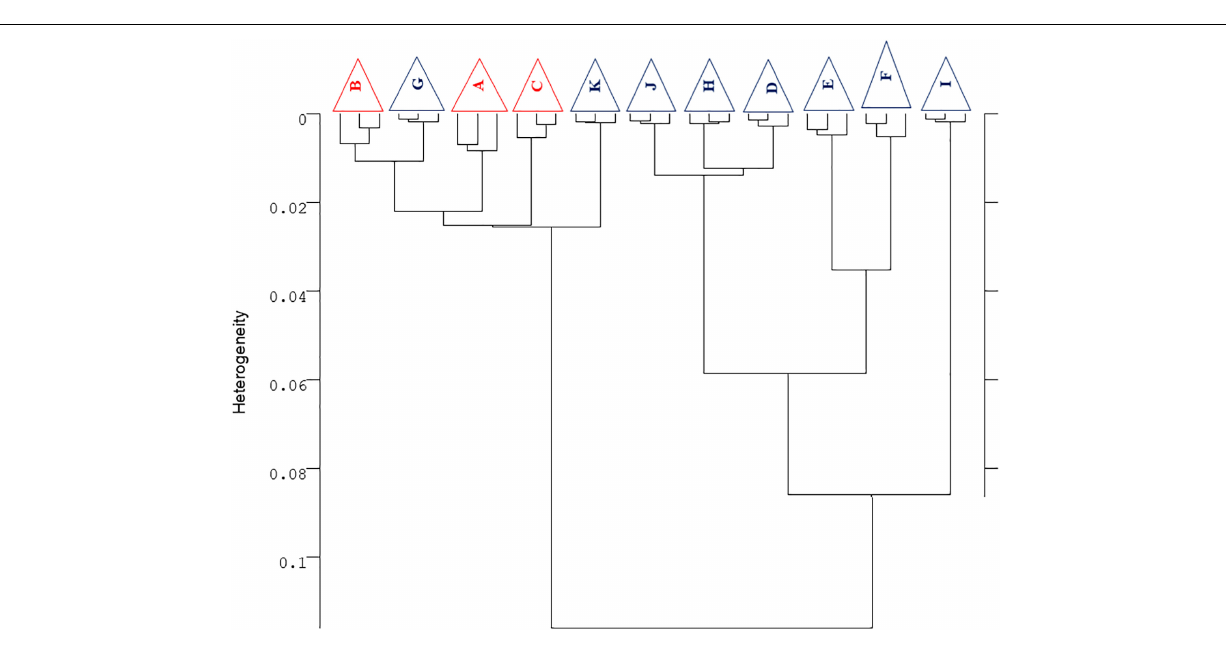
FIGURE 6 | Hierarchical cluster analysis of FTIR second derivative normalized spectra obtained from the yeast strain AWRI 796 (AW) inoculated in grape must (red samples) and synthetic must (blue samples) in eleven different trial sites. The dendrogram was obtained by calculating the Euclidean distance between whole IR spectra. For each RU, three biological replicates were considered (displayed by a triangle when the replicates clustered